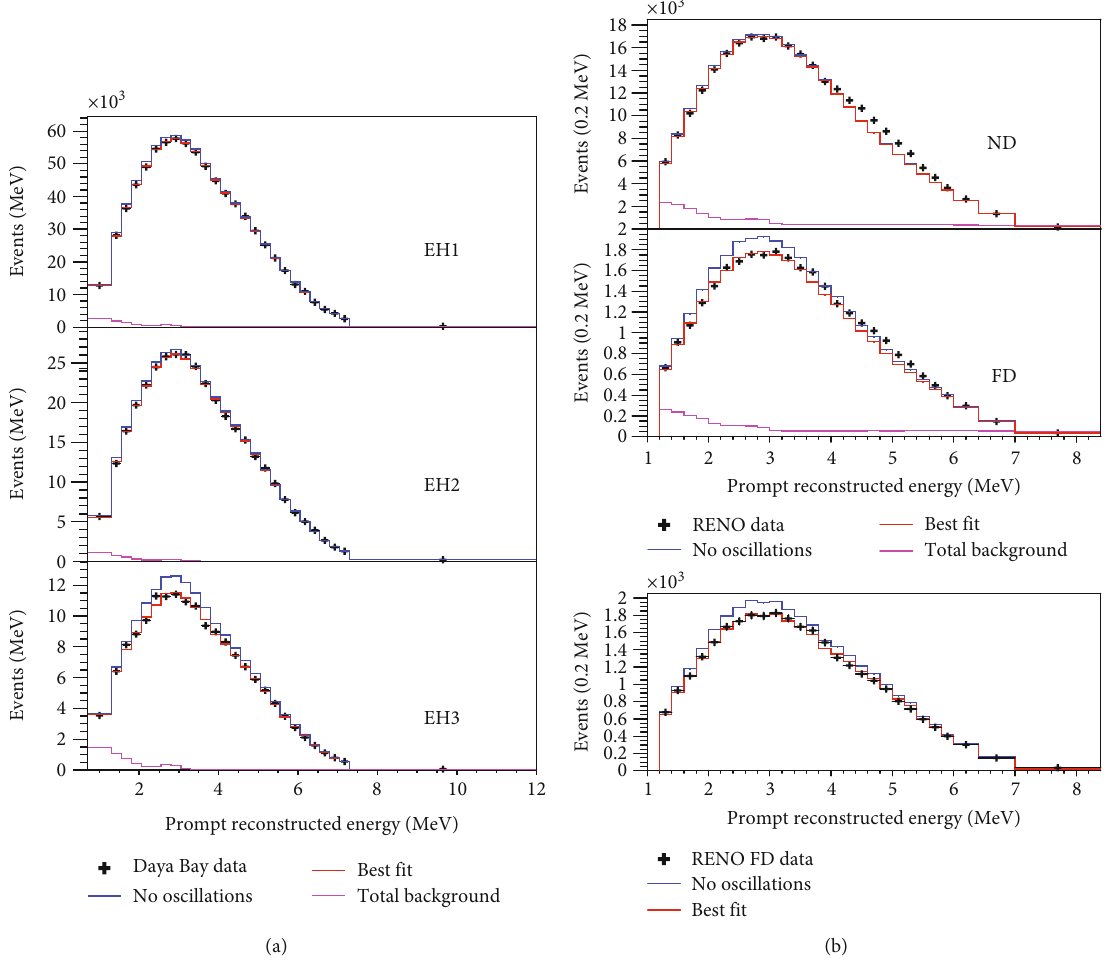
Figure 3: Background-subtracted reconstructed positron prompt energy distributions for Daya Bay (a) and RENO (b). Black crosses are data; blue (red) line histograms show the MC expected no-oscillation (best fi t) spectra. The background histograms are shown in magenta. See text for details. For Daya Bay, the distributions are absolutely normalized and account for the 5 MeV bump e ff ect. For RENO, the predicted ND and FD distributions are normalized such that the best fi t and data histograms have equal areas outside the 5MeV bump region ( 3 : 8 MeV < E p < 6 : 4MeV ). The bottom-right plot (RENO) compares the observed spectrum in the FD with no oscillation and the best- fi t predictions obtained from the measurement at the ND, which account for the e ff ect of the 5MeV